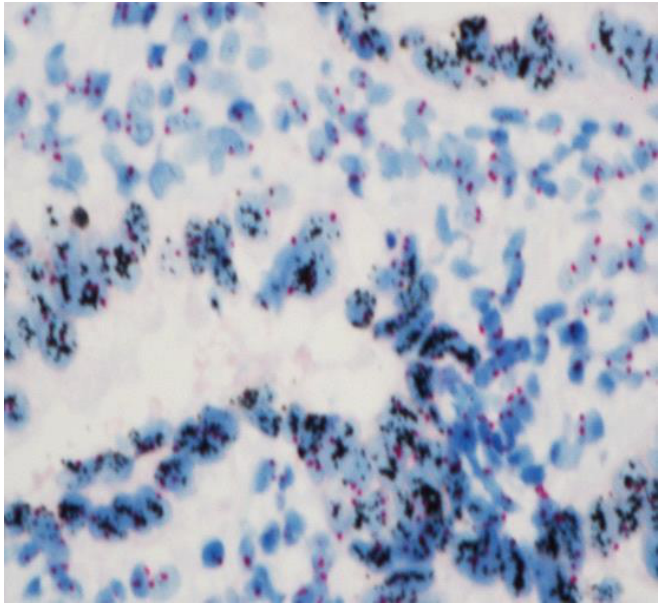
Figure 3. HER 2-amplified endometrial carcinomas with clusters of HER2 signals in black clearly contrasting with the 2 red signals (Chr 17) at ×40.